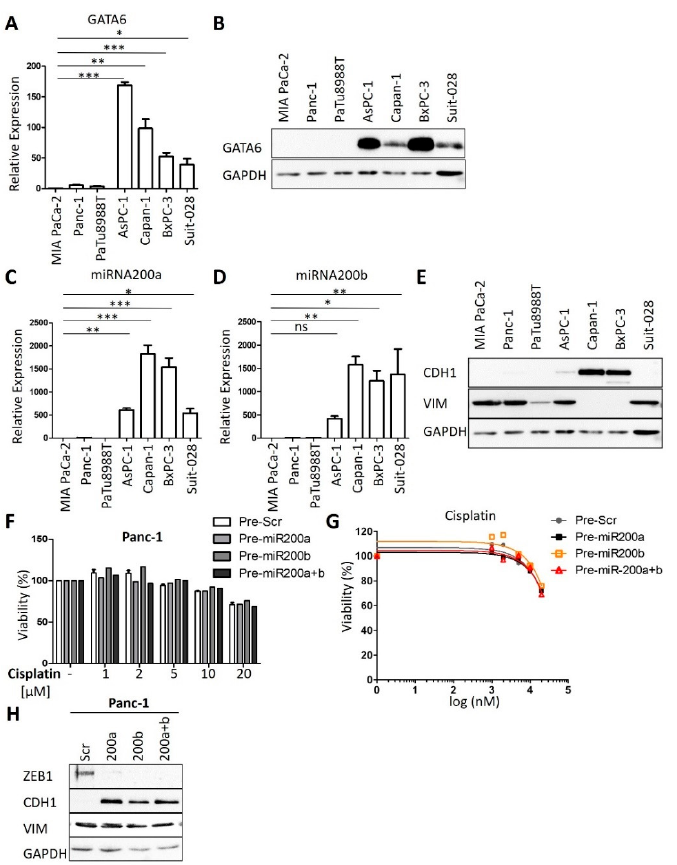
Figure 2. GATA6, miRNA200a, and 200b serve as markers for cisplatin sensitivity. ( A ) Expression analysis of GATA6 in PDAC cell lines by qRT-PCR, normalized to the mRNA of RPLP0. Mean ± SD of three biological replicates. ( B ) Immunoblot analysis of GATA6 in PDAC cell lines. GAPDH served as the loading control. ( C , D ) Expression analysis of ( C ) miRNA-200a and ( D ) miRNA-200b in the panel of cell lines. snRNA U6 was used for normalization. Mean ± SD of three biological replicates. ( E ) Immunoblot to detect epithelial marker E-cadherin (CDH1) and the mesenchymal marker vi- mentin (VIM). ( F , G ) Panc-1 cells were transfected with Pre-miRNA-200a and 200b for 48 h and re- transfected for 24 h. After treatment with different concentrations (1 µM to 20 µM) of cisplatin for 72 h, cell viability was measured. Mean ± SD of three biological replicates. ( H ) Immunoblot analysis of Panc-1 cells after transfection as described in ( F ). Staining of the miR-200 target gene product Zeb- 1, E-cadherin (CDH1), and Vimentin (VIM). GAPDH was stained as the loading control. ( A , C , D ) p values were calculated with one-way ANOVA comparing the indicated groups. ns = not signifi- cant, * p ≤ 0.05, ** p ≤ 0.01, and *** p ≤ 0.001. 3.3. HSP90 Inhibitors Synergize with Cisplatin, Reduce Fanconi Anemia Pathway Mediators, and Sustain DNA Damage Next, we sought to evaluate an approach to sensitize the resistant PDAC cells to- wards cisplatin therapy. We applied a strategy that we had previously found effective in ovarian cancer cells, i.e., combining a platinum drug with inhibitors of the HSP90 chaper- one [13]. Indeed, this combination also decreased the viability of resistant PDAC cells in